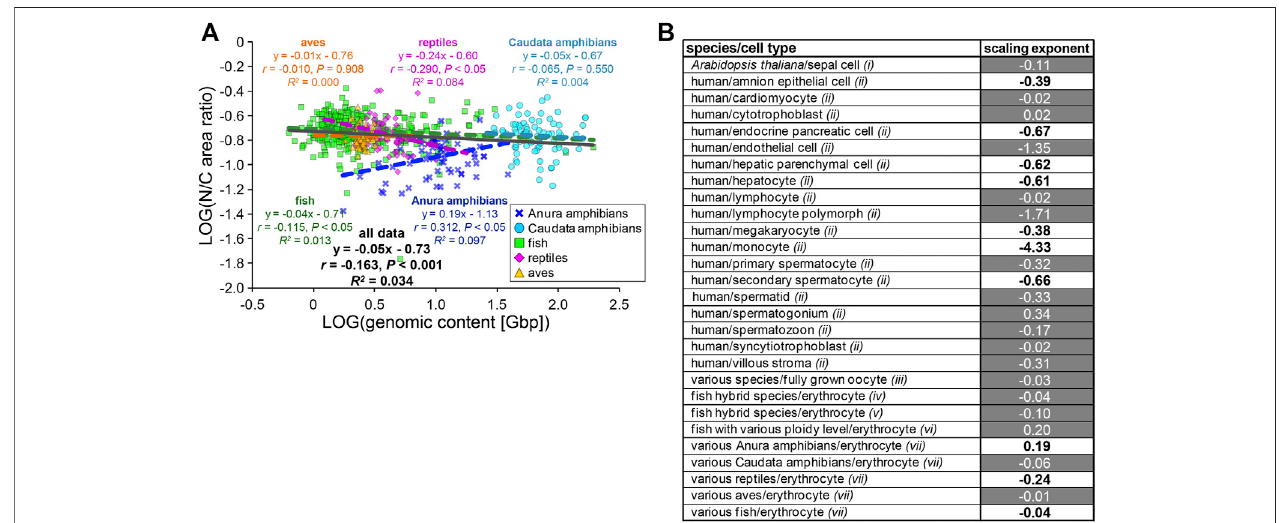
FIGURE 5 | Comparison of N/C area ratio with genomic content. (A) Collected N/C area ratios were plotted against the genomic contents in a log-log plot. Anura amphibians: n =71;Caudataamphibians: n =80; fi sh: n =317;reptiles: n =62;aves: n =124.Theequationfortheregressionline,Pearson ’ scorrelation( r ), P values,and the coef fi cient of determination ( R 2 ) have been indicated in the plot. (B) Calculated scaling exponents of the N/C area ratio to the genomic content in each dataset from single cell-types with different ploidy levels, from single species or various species. Datasets were collected from published papers; i : measured from graphs in Robinson et al., 2018; ii : listed in Gillooly et al., 2015; iii : listed in Hara, 2020; iv : measured from images in Lu et al., 2009; v : measured from images in Hu et al., 2016; vi : listedinGaoetal.,2007; vii :thisstudy.Blackandwhitevaluesinthecolumnrepresentsampleswiththestatisticallysigni fi cant( p < 0.05)correlations( r )andnosigni fi cant correlation,